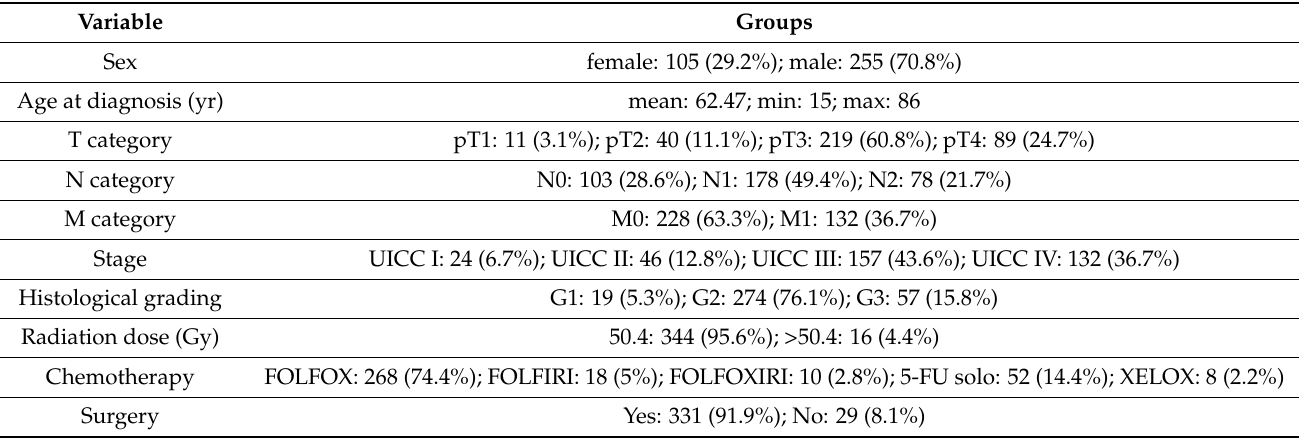
Table 1. Clinical